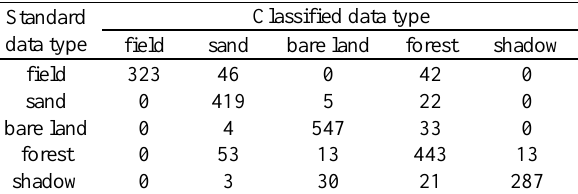
Table 4. Error matrix of 1-V-1 SVMs classification